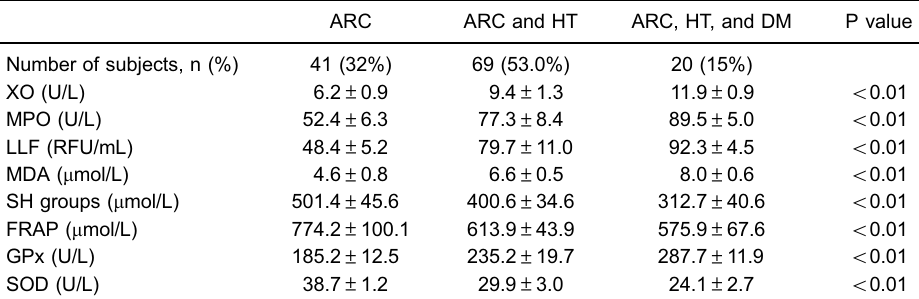
Table 2. Markers of lipid peroxidation and antioxidant enzyme activities in the blood of